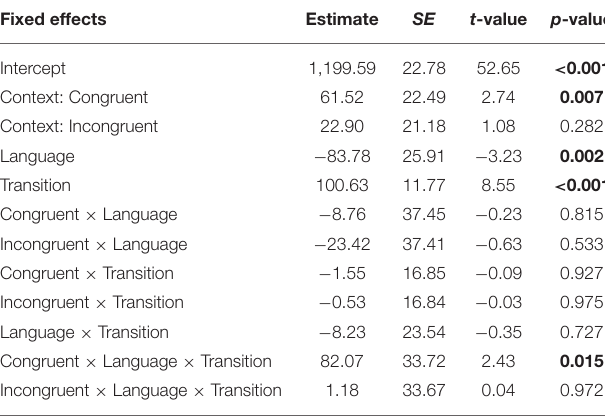
TABLE 4 | Mixed-effects model for